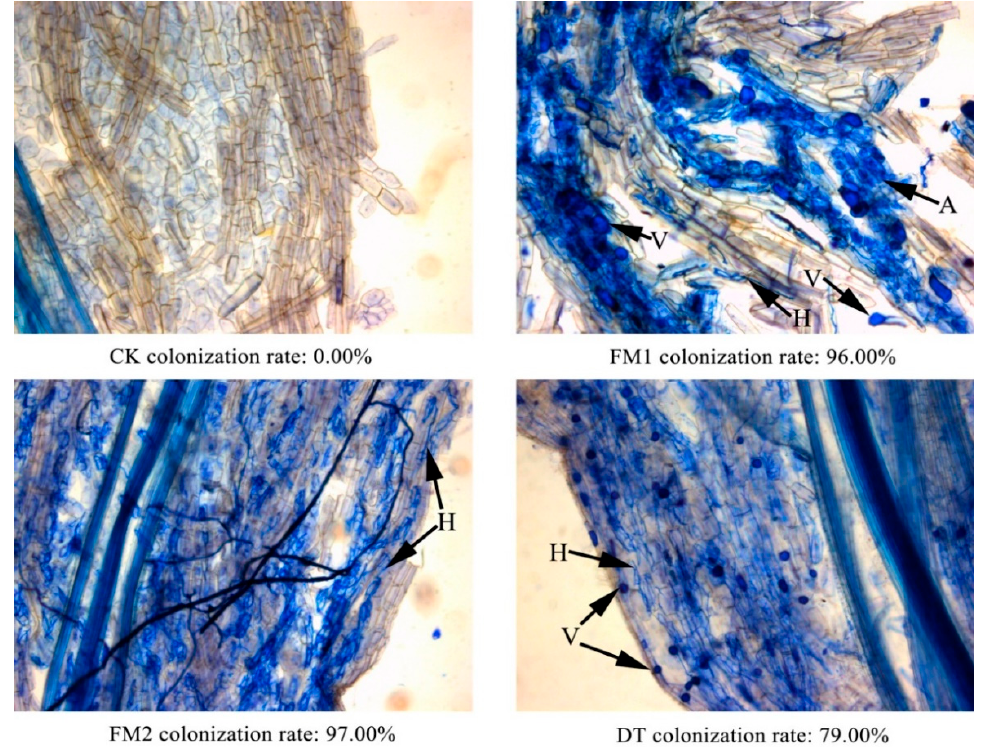
Figure 1. Development and colonization rates of arbuscular mycorrhizal fungi in G. sinensis seedling roots. CK — treatment of non-inoculation. FM1 — treatment inoculated with F. mosseae 1. FM2 — treatment inoculated with F. mosseae 2. DT — treatment inoculated with D. tortuosum. V — vesicle, H — hypha, A — arbuscule. Table 1. Effects of arbuscular mycorrhizal fungi (AMF) on G. sinensis seedling growth, biomass and mycorrhizal dependence.